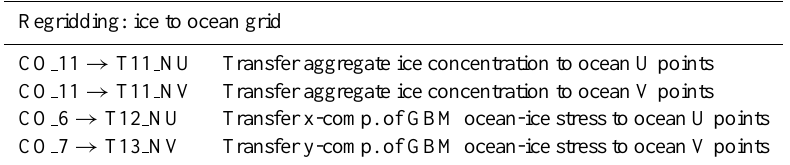
Table 1c. Detail of regridding the ice fields onto the ocean U and V points in Fig. 4. These manipulations are in the NEMO subroutine CICE SBC OUT